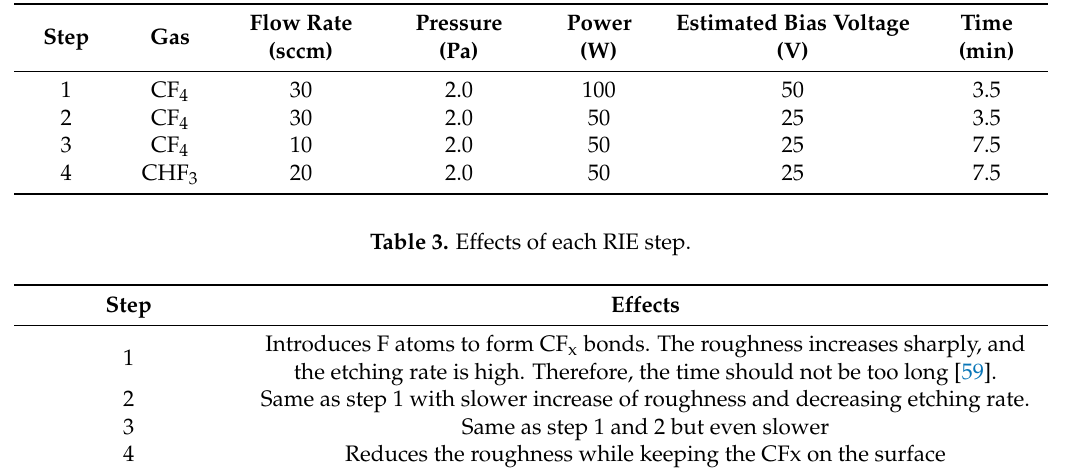
Table 2. RIE workflow for the surface modification of a CTA/PLGA dielectric layer.